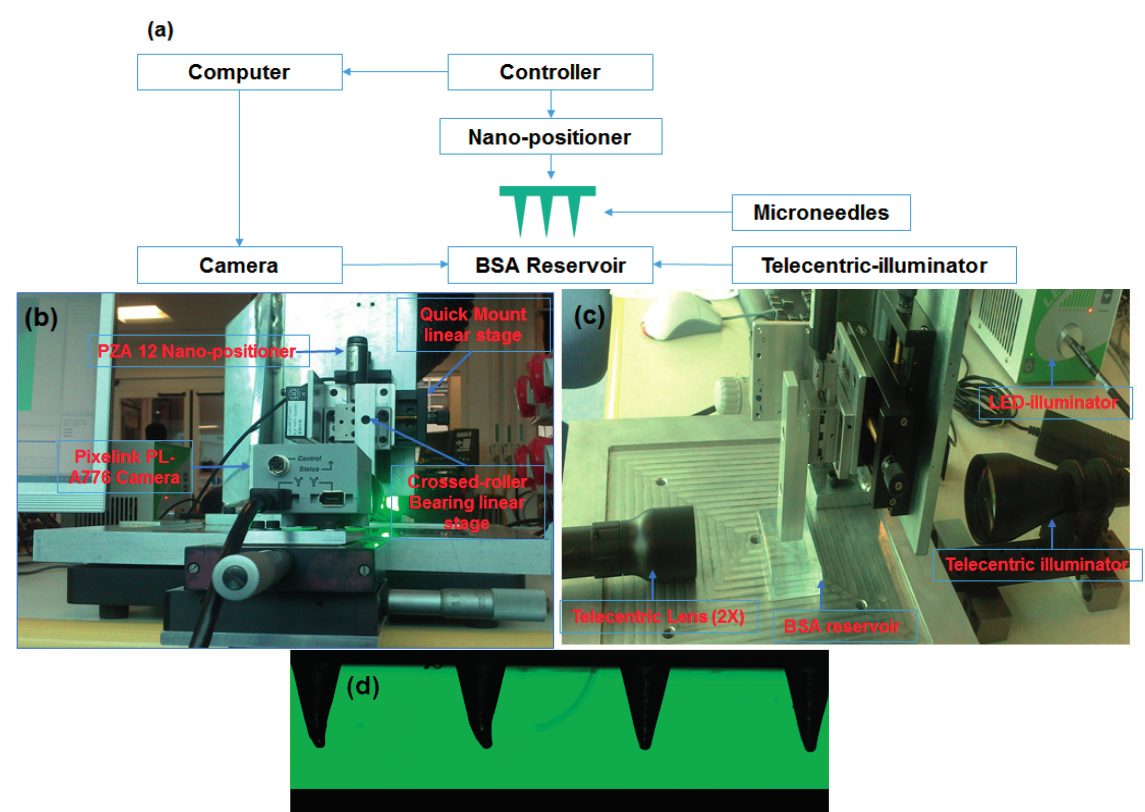
Figure 2. ( a ) Schematic of the nano-positioner dip coating set up; ( b ) photograph of dip coating apparatus showing individual components; ( c ) side view showing the lens and the BSA reservoir; ( d ) microneedle array as seen from the software before dip